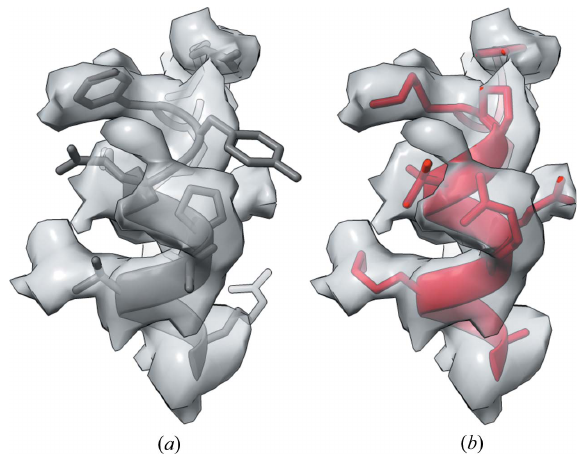
Figure 5 Fragment of an S21 protein model from E. coli 70S ribosome at 3.0 A˚ resolution (PDB ID/EMDB ID 5we4/8814). ( a ) In the deposited coordinates, many side chains outside a well resolved map and a proline inside a regular alpha helix may raise suspicion. ( b ) After sequence re- assignment and side-chain rebuilding with findMySequence , the map features are better explained by the model. Only residue range 34–44 in chain u and a corresponding map are shown for